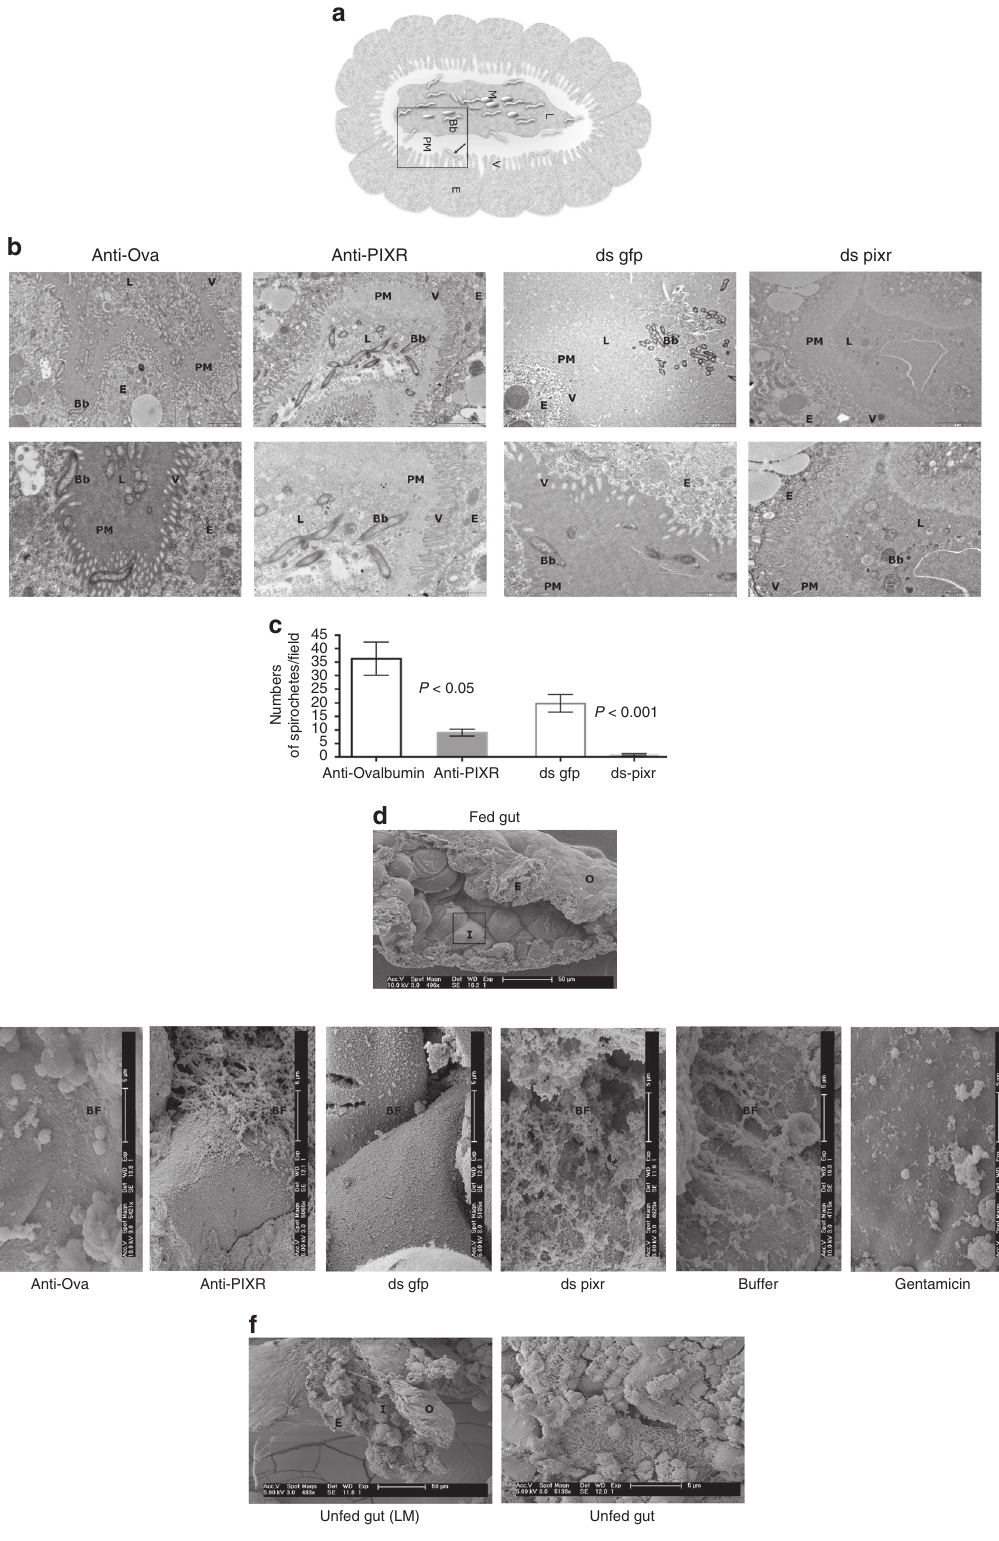
guts of nymphs that fed on PIXR-immunized mice when compared to sparse bio fi lms in the guts of nymphs that fed on Ovalbumin-immunized mice (Fig. 4e). ds pixr RNA-mediated knockdown of pixr also provided a similar increase in the bio fi lm-